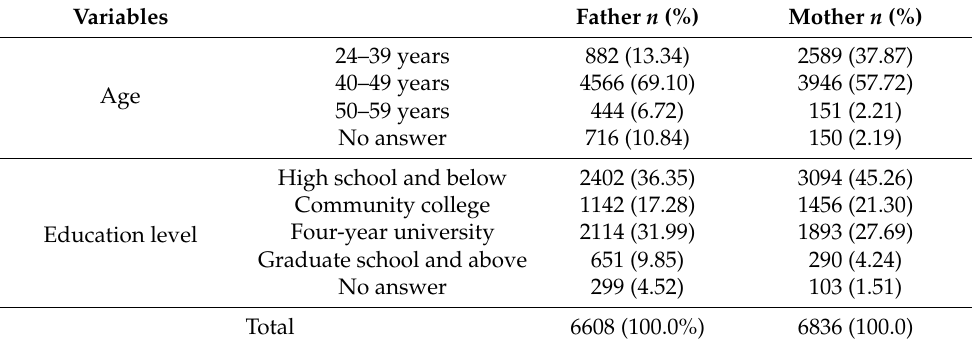
Table 1. Parents’ Demographics: Frequency and Percentage of Age and Education